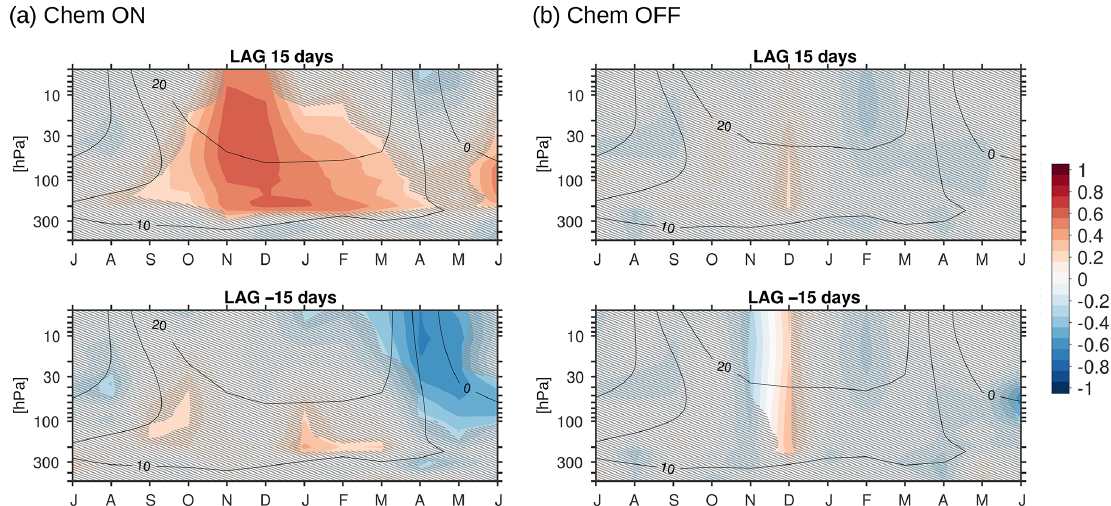
Figure 5. Correlation between polar cap (70 to 90 ◦ N) ozone at 50hPa and polar cap dynamical heating rates in (a) Chem ON and (b) Chem OFF for ozone lagging by 15 days (LAG 15 days) and ozone leading by 15 days (LAG − 15 days). Statistically insignificant areas are hatched at the 95%